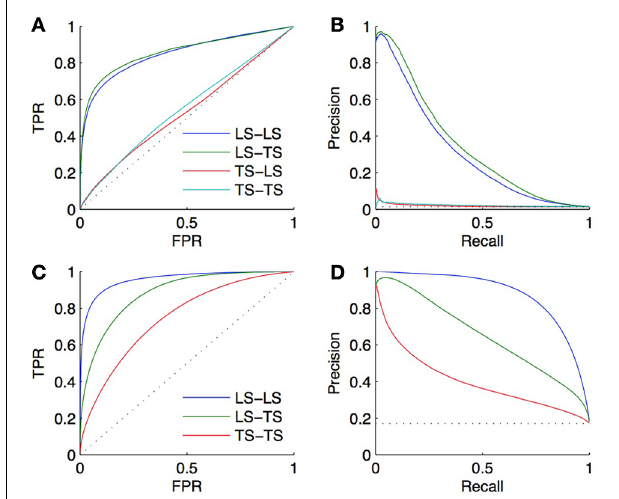
FIGURE 5 | ROC curves (A) and PR curves (B) for the four groups of predictions obtained by 10-fold CV on the DREAM5 artificial gene regulatory network. AUROC are, respectively, equal to 0.85, 0.86, 0.53, and 0.55 and AUPR are equal to 0.31, 0.34, 0.02, and 0.02. The performance of prediction of a pair involving a gene and a TF present in the learning set ( LS × LS ) is as good as the performance of prediction of a pair involving a gene absent and a TF present in the learning set ( LS × TS ). On the contrary, predicting an interaction involving a new TF is much more difficult ( TS × LS and TS × TS ). Bottom: ROC curves (C) and PR curves (D) obtained by 10-fold CV on the corresponding DREAM5 co-regulatory network. AUROC are, respectively, equal to 0.96, 0.88, and 0.75 and AUPR are equal to 0.88, 0.65, and 0.40. Predictions on pairs involving two genes from the learning set are the best, while predictions on pairs involving two genes from the test set are the worst.